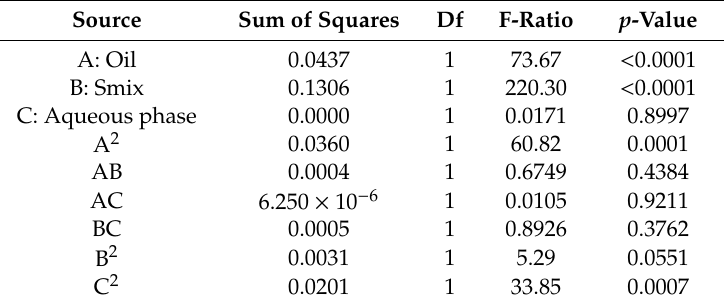
Table 3. Analysis of variance data for polydispersity index